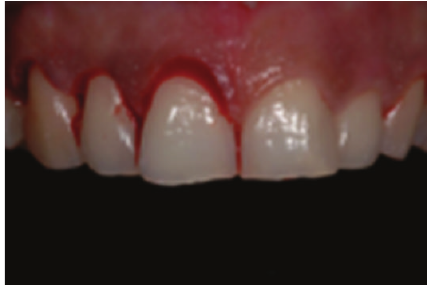
Figure 9: Real anatomy compared to altered passive eruption.